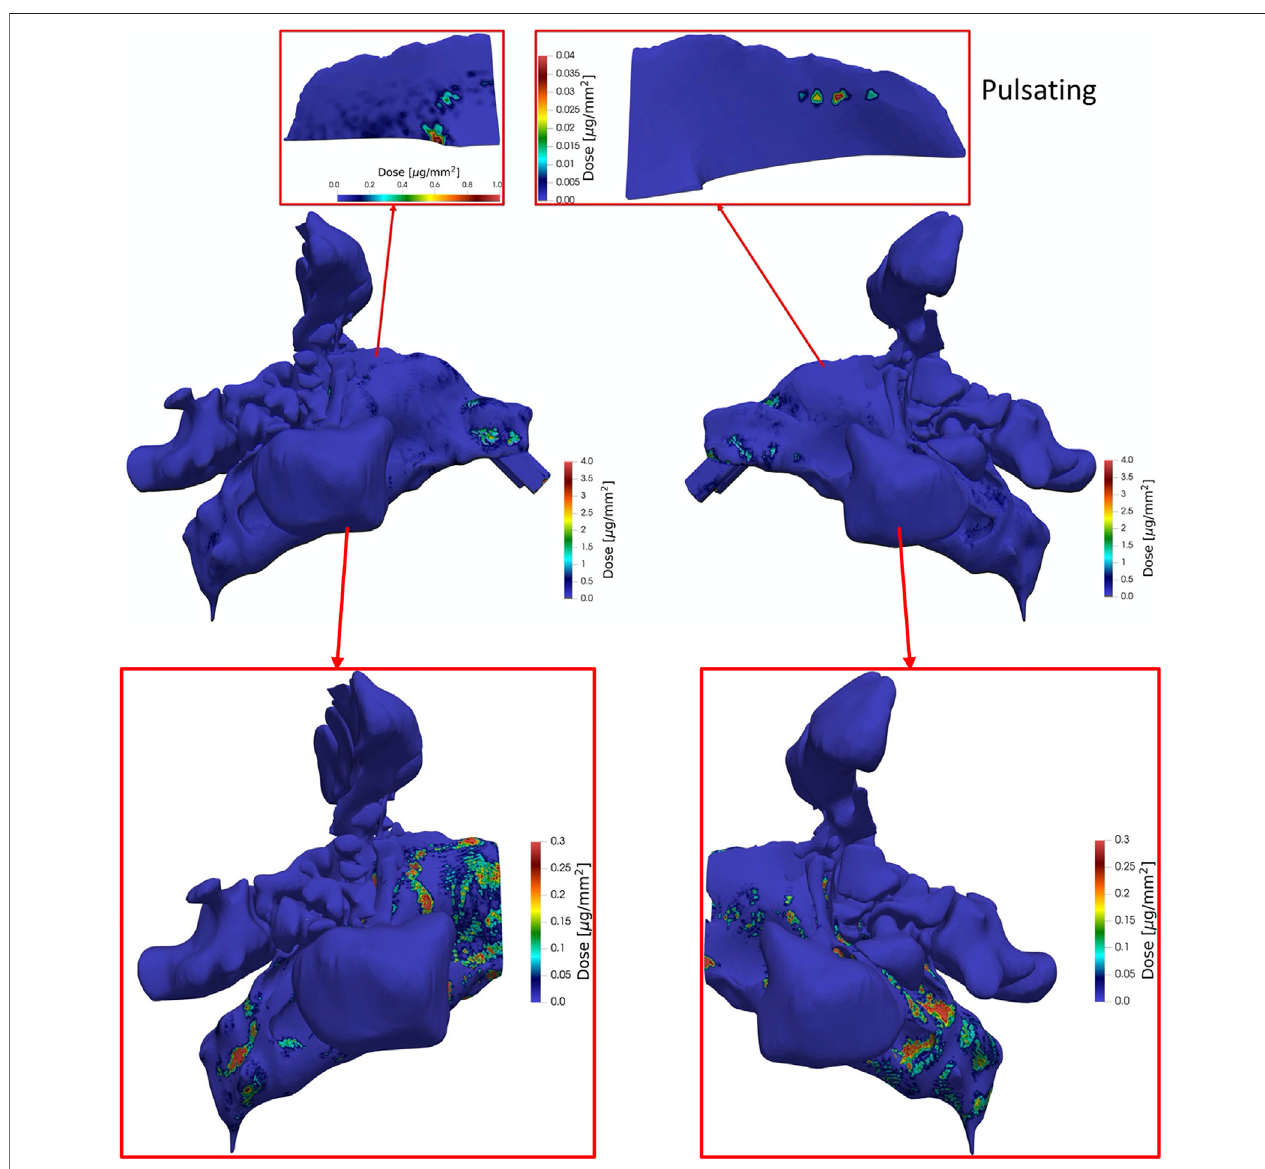
FIGURE12| Sameas Figure11 exceptthatpulsatingaerosoldeliverywithpulsation fl owrateof4 L/minandfrequencyof45 Hzat t (cid:2) 1.98 s(endofinhalation)was applied.